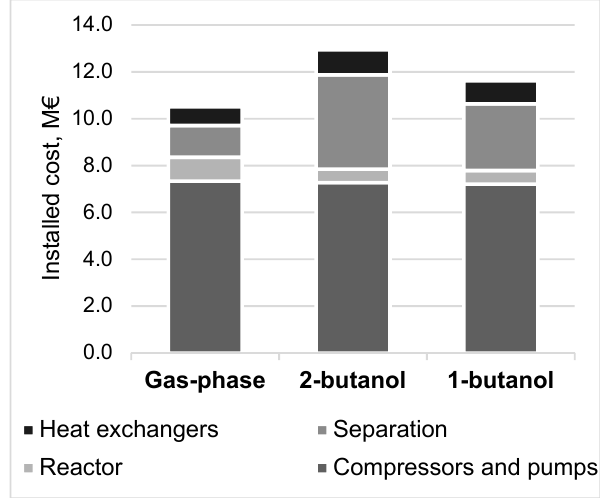
Figure 7. Installed equipment costs by type in three CO 2 hydrogenation to methanol processes: the gas-phase process, the liquid-phase process with 1-pentanol solvent, and the liquid-phase process with 1-pentanol solvent and solvent recovery by decantation. Separation included distillation, flash, and decanter vessels.